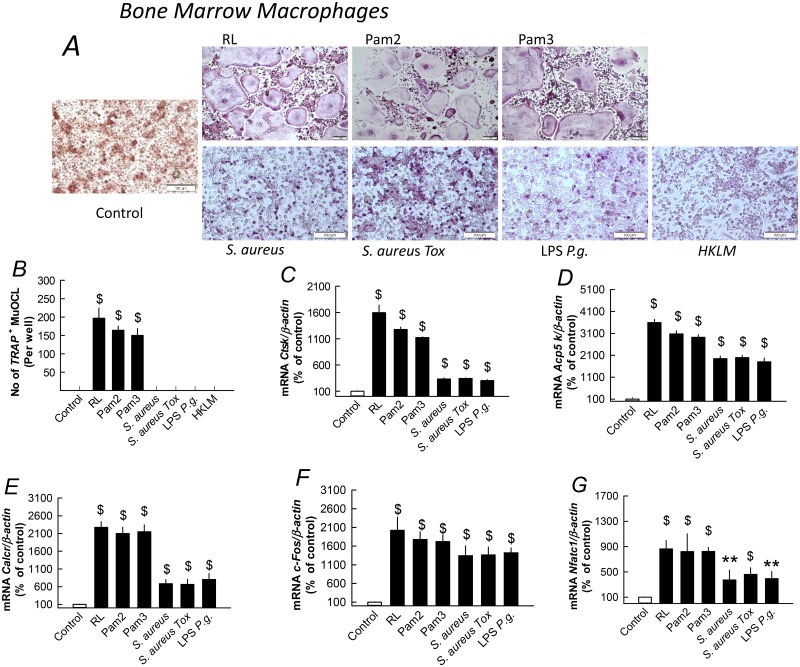
Pam 2 and Pam3 stimulate mature osteoclast formation, whereas S. aureus, LPS P. gingivalis and HKLM stimulate differentiation of mononuclear osteoclasts in RANKL-primed bone marrow macrophage cultures.Bone marrow macrophages were primed for 24 h in either M-CSF (30 ng/ml) or in M-CSF with RANKL (4 ng/ml). Then, cells were treated with M-CSF (controls) or with M-CSF and either RANKL (RL; 4 ng/ml), Pam2 (100 ng/ml), Pam3 (100 ng/ml), S. aureus (107 CFU/ml), S. aureus Tox (107 CFU/ml), LPS P. gingivalis (P.g.; 10 μg/ml) or HKLM (3x107 UFC) for 96 h. (A, B) RL, Pam2 and Pam3 stimulated formation of TRAP+ multinucleated osteoclasts, whereas S. aureus, LPS P. gingivalis and HKLM stimulated TRAP+ mononucleated osteoclasts. (C-D) Effects by RL, Pam2, Pam3, S. aureus, S. aureus Tox, LPS P. gingivalis and HKLM on mRNA expression of Ctsk, Acp5, Calcr, c-Fos and Nfatc1 in RANKL-primed bone marrow macrophages. Data are means of 6 observations and SEM is given as vertical bars. $P>0.001 and **P<0.01 compared to unstimulated control.